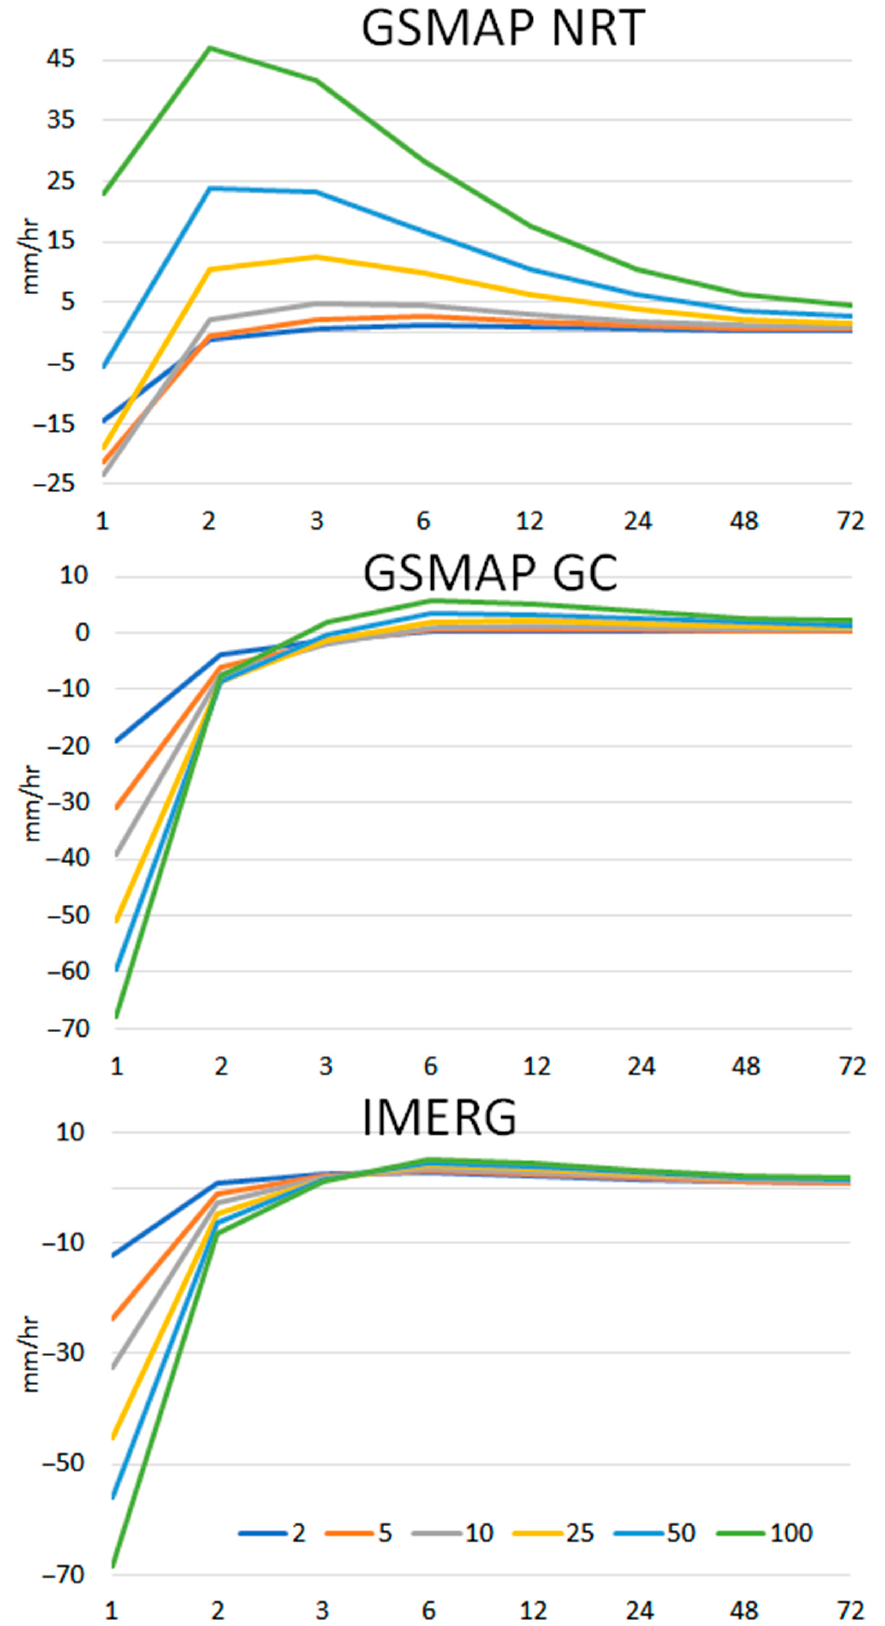
Figure 12. Bias in IDF curves in GSMaP NRT, GSMaP GC, and IMERG data compared to observation at Mosul.